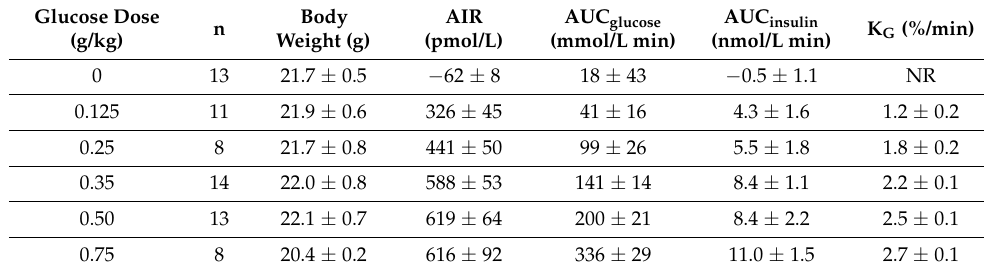
Table 1. Body weight, acute insulin response (AIR), suprabasal (incremental) areas under the 0–60 min curves (AUC) for glucose and insulin levels, and glucose elimination rate (K G ) after intravenous administration of glucose at different dose levels in C57BL/6J mice. Means ± SEM are shown. n indicates the number of animals in each group. NR not